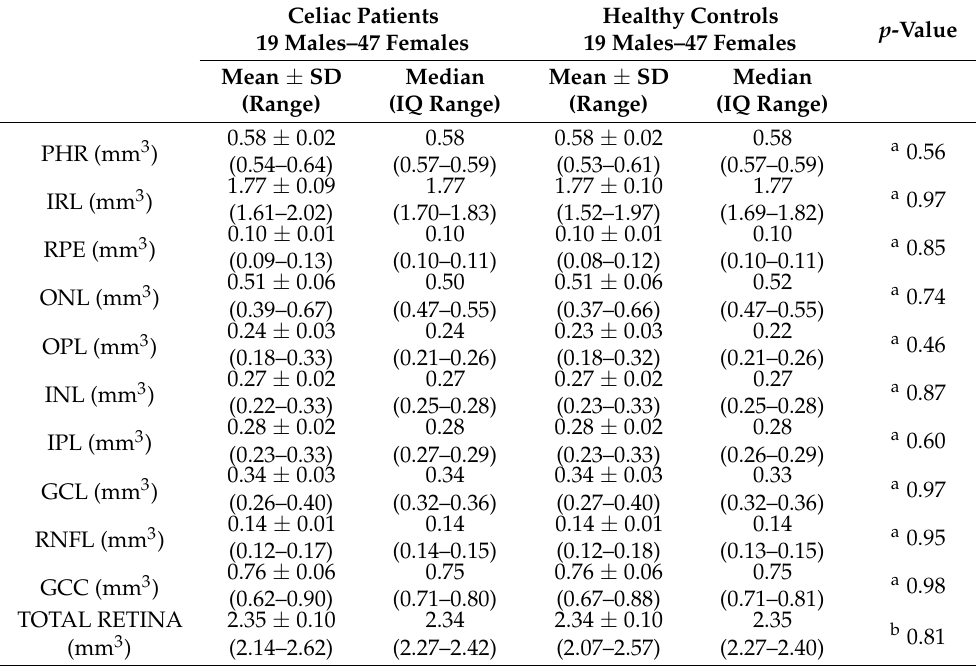
Table 4. Comparison of total volume (mm 3 ) between celiac patients and healthy subjects of the analyzed OCT